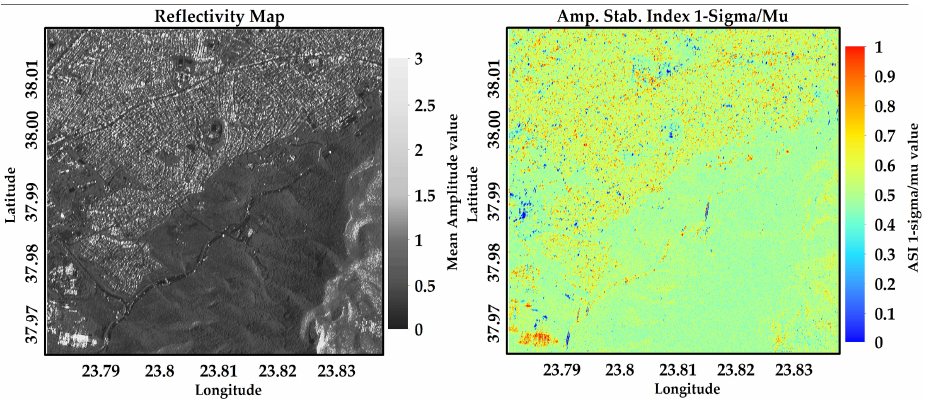
Figure 6. Geocoded Reflectivity Map on the left and geocoded ASI 1-sigma/mu on the right (example of Descending VV data).